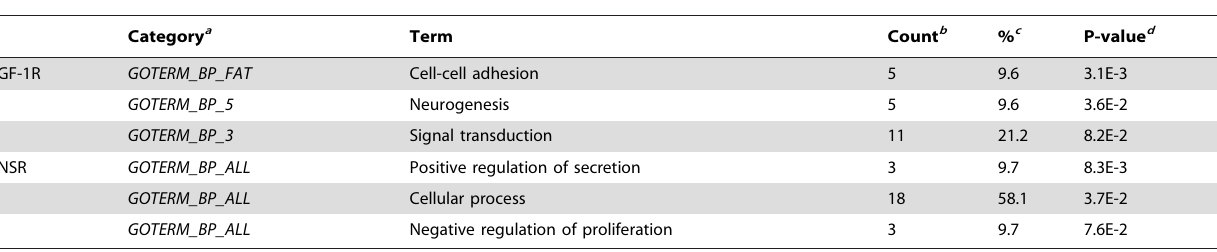
Table 3. Gene ontology clustering of gene